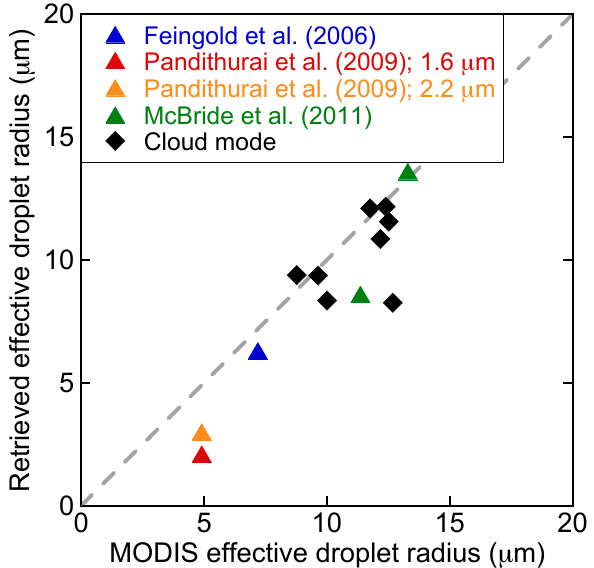
Fig. 13. Same as Fig. 1, but for intercomparison to MODIS- retrieved cloud effective droplet radii only. Cloud-mode retrievals Fig. 13 . Same as Fig. 1, but for intercomparison to MODIS-retrieved cloud effective droplet 3 are based on eight cases listed in Table 6. radii only. Cloud-mode retrievals are based on eight cases listed in Table 6. 4